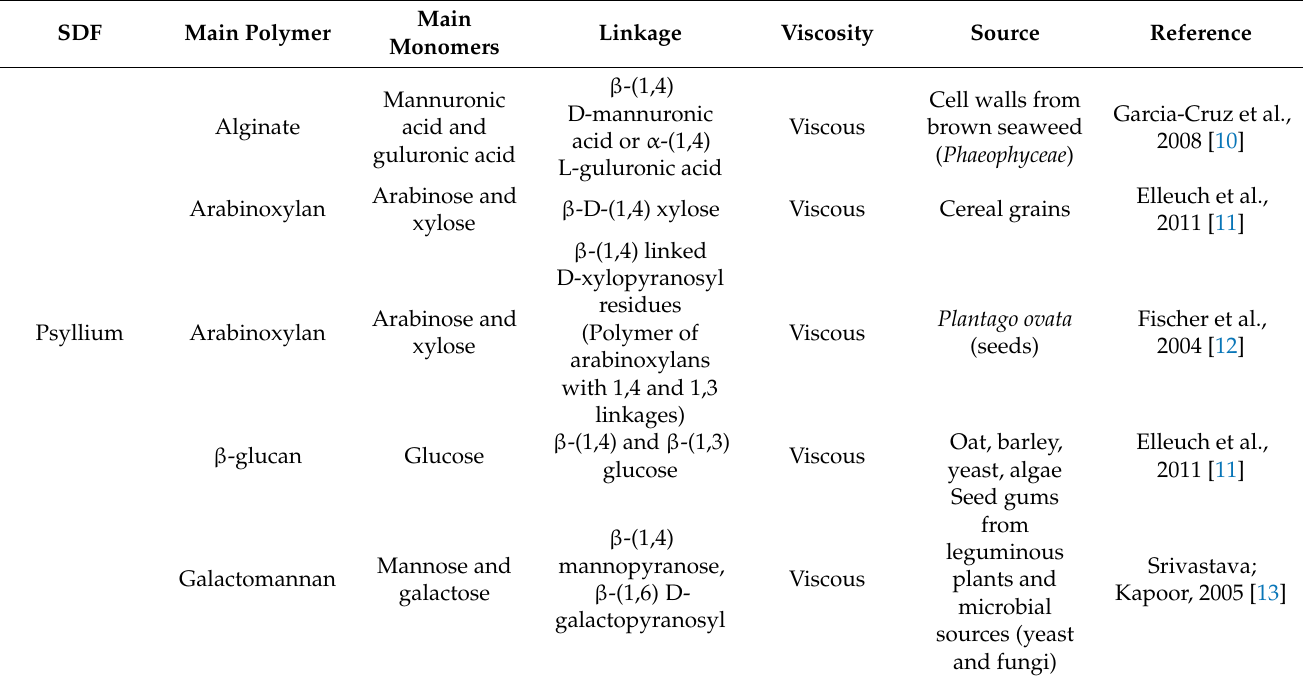
Table 1. Examples of soluble dietary fiber (SDF), characteristics, and